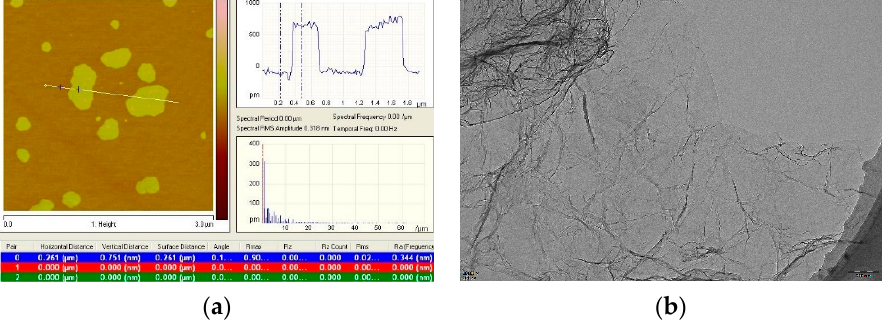
Figure 1. ( a ) Graphene properties from AFM, and ( b ) graphene morphology from TEM.